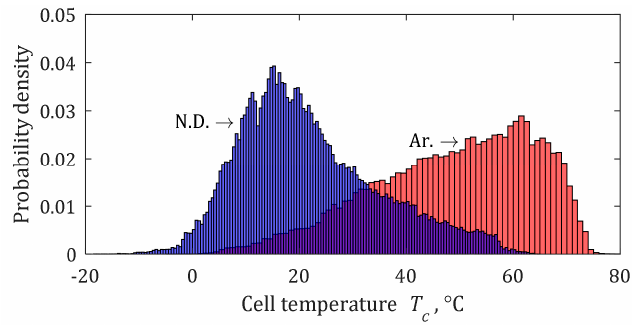
Figure 12. Density distribution of the cell temperatures.